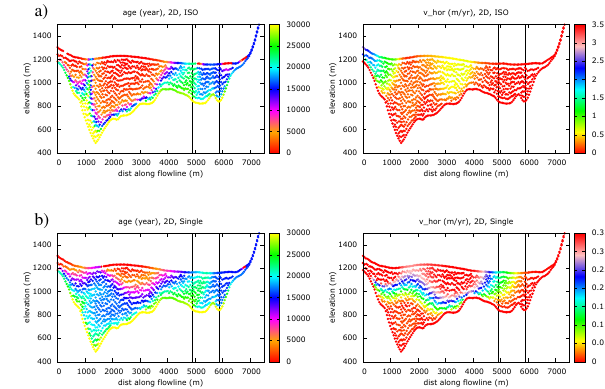
Fig. 10. Ages (left column) and absolute horizontal velocity (right column) of the 2-D flow-line model using (a) isotropic Glen’s flow law, (b) single maximum fabric distribution (mind the different velocity scale). The two vertical lines mark the intersection with the horizontal ice core at points V and H.